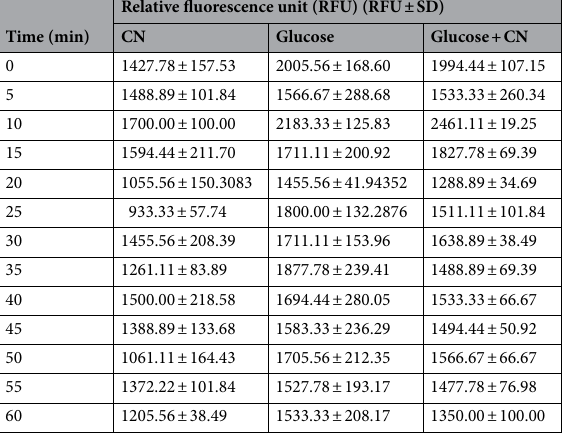
Table 2. Fluorescent readings of efflux assay conducted on KPC-KP